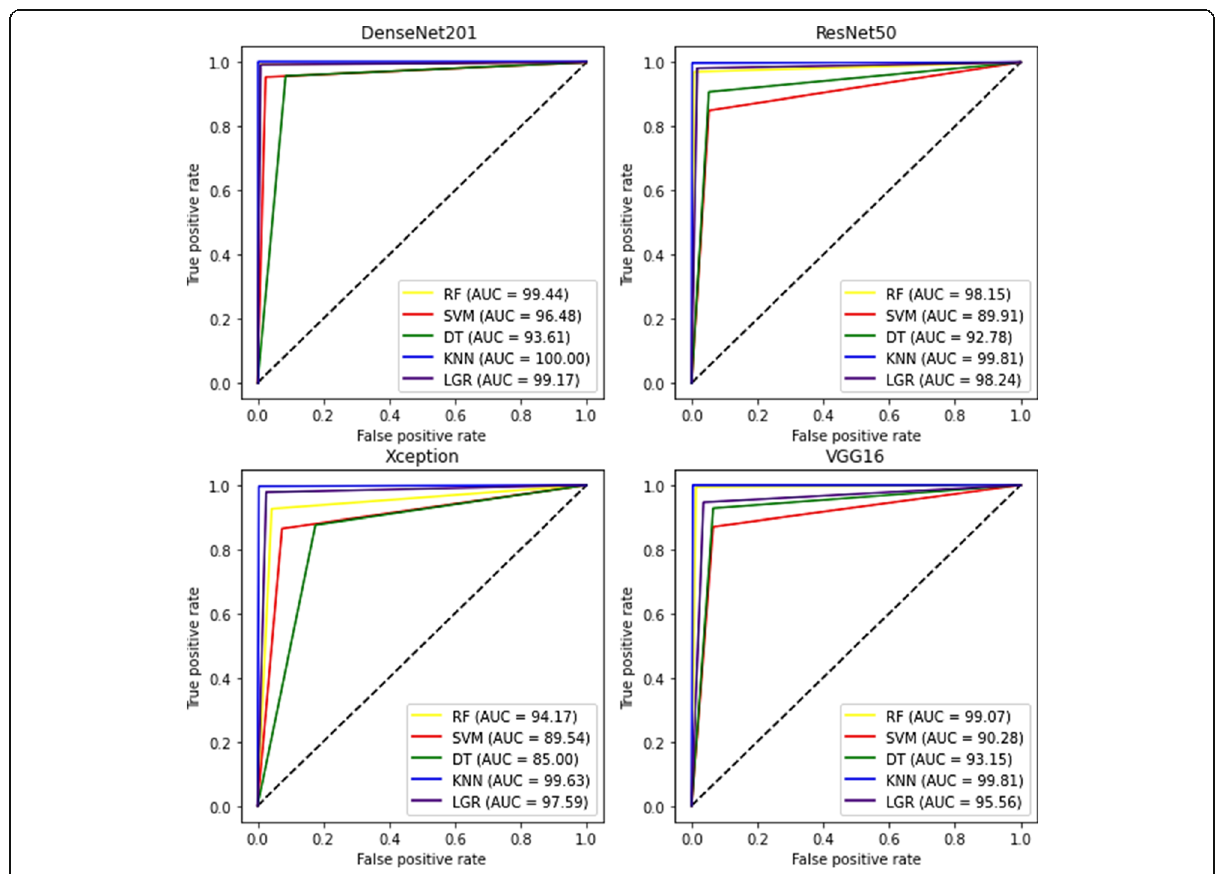
Fig. 7 ROC plots of the pre-trained models in combination with five ML